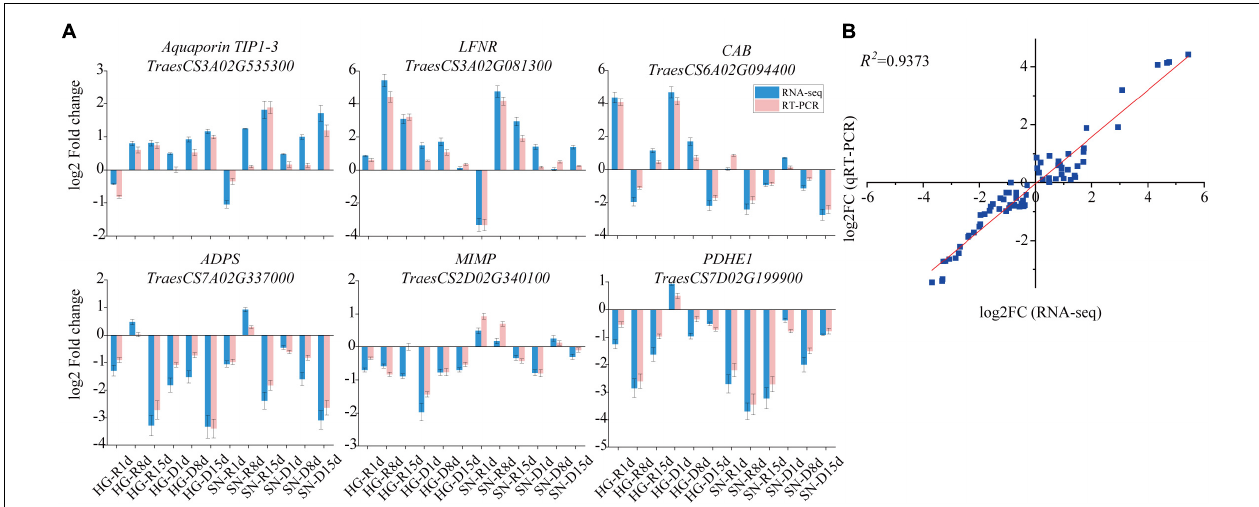
FIGURE 9 | The expression profiles of six randomly selected DEGs were validated by qRT-PCR assay. (A) The expression patterns of six randomly selected DEGs were generated using both qRT-PCR data and FPKM values. The relative transcript abundances were expressed relative to that of the internal reference TaActin following the 2 − (cid:49)(cid:49) Ct method. FPKM values of these DEGs were collected from the transcriptome database. (B) Correlation analysis on the overall expression levels of six selected DEGs between RNA-seq and qRT-PCR. Log2FC values of RNA-seq data (x-axis) were plotted against log2FC values of qRT-PCR data (y-axis). R, rehydrated plants; D, plants under continuous drought